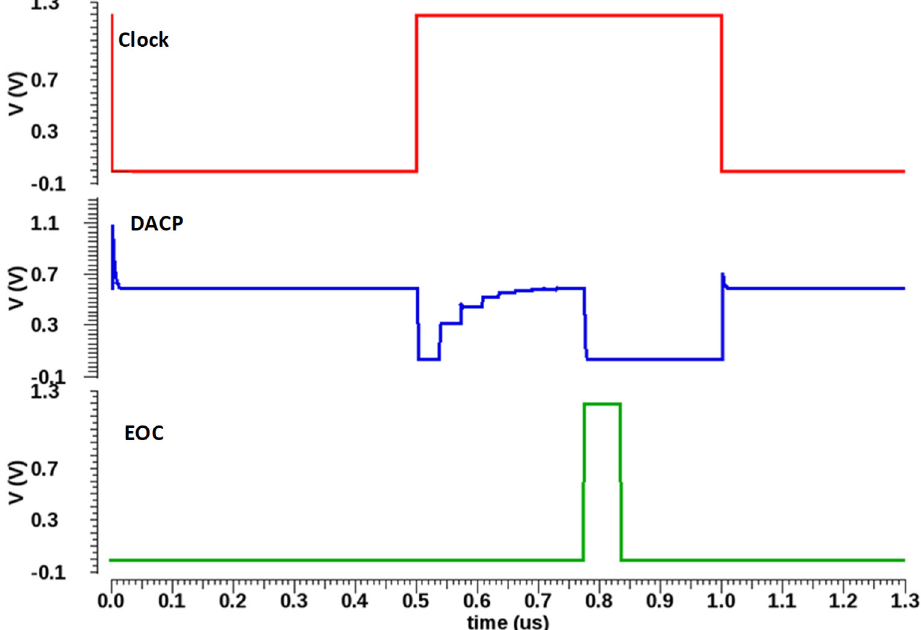
Figure 6. Simulation result of capacitive DAC.